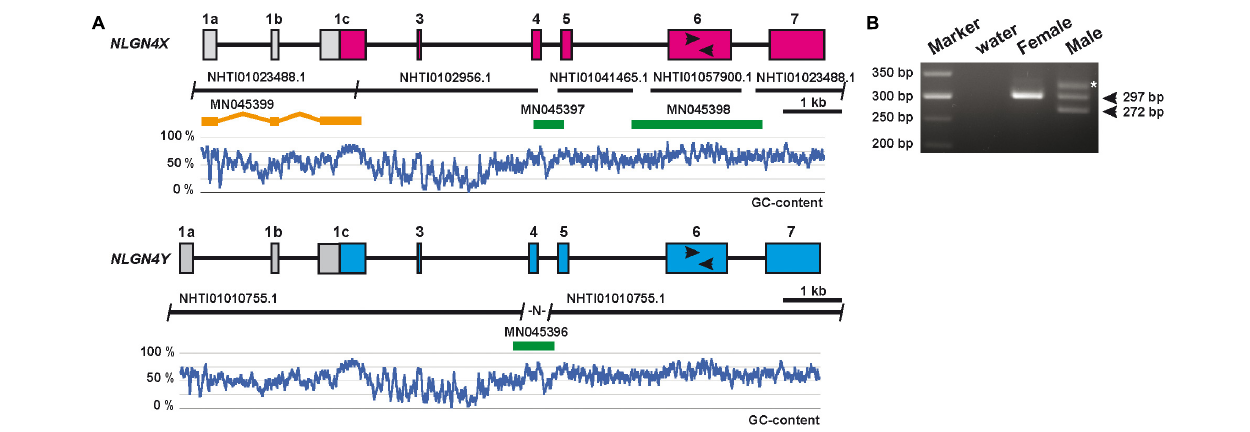
FIGURE 1 | Schematic of the genomic organization of the gerbil NLGN4X/Y genes. (A) The information of five nucleotide sequences (“NHTI” accession numbers on black bars) were used to assemble a draft of two independent NLGN4 -like genes in gerbils. Three sequence gaps in NLGN4X and one gap in NLGN4Y were closed by PCR amplification using gerbil genomic DNA (PCR fragments are depicted in green and labeled with respective accession numbers). A reverse oligo was placed at the 3 (cid:48) prime end of exon 1c to allow for the amplification of a 5 (cid:48) RACE fragment from brain cDNA of a female gerbil (MN045399). The 5 (cid:48) RACE fragment is displayed as three separate orange bars to appreciate the exon/exon junctions framing two additional upstream exons, 1a and 1b, from the genomic sequence information. A set of black arrows represent the location of oligonucleotides that allow the amplification of NLGN4X - and NLGN4Y -specific PCR amplicons. Below each gene the relative GC-content is depicted as a moving average of a 30-base frame. (B) Representative PCR result of amplicons based on a length polymorphism within exon 6 in the respective NLGN4X and NLGN4Y genes. The lower molecular weight band reflects the presence of NLGN4Y (272 bp), the higher one in both samples NLGN4X (297 bp). An asterisk marks an additional band present in the sample of a male